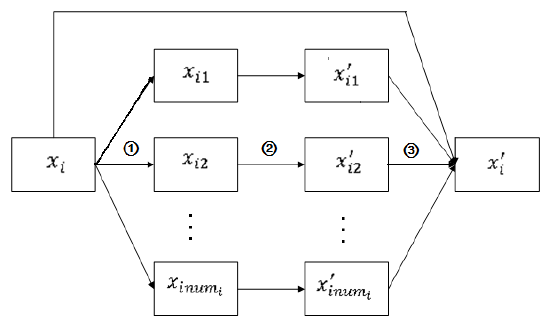
Fig. 1. Clone, HyperMutation and Clonal Selection